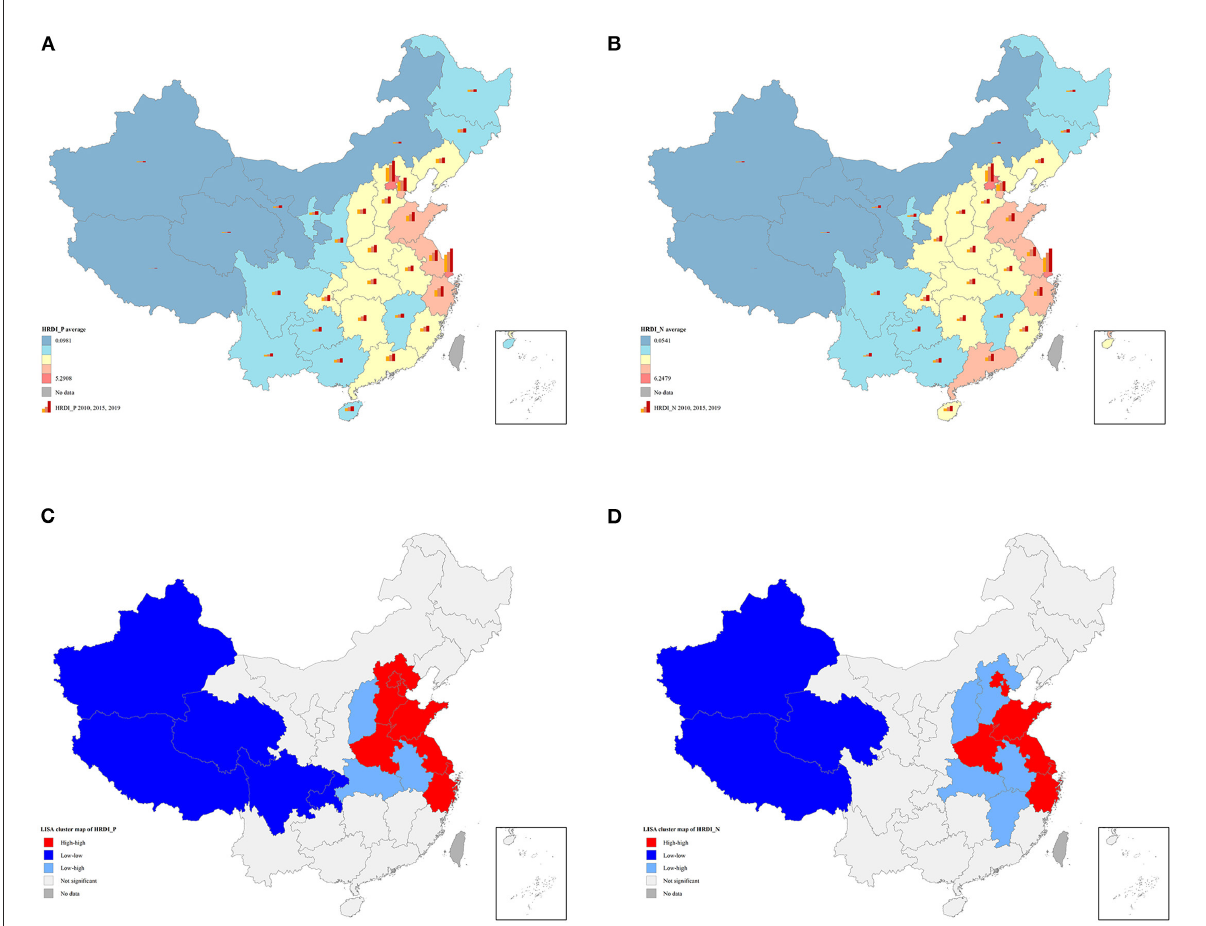
FIGURE2 (A) Spatial distribution of HRDI_P; (B) spatial distribution of HRDI_N; (C) univariate local indicator of spatial association cluster map of HRDI_P in 2019; (D) univariate local indicator of spatial association cluster map of HRDI_N in 2019. The average value of HRDI_P and HRDI_N in (A,B) was divided into five levels based on natural breaks (Jenks). These figures are drawn based on the standard map from the Resource and Environment Science and Data Center (https://www.resdc.cn/Default.aspx).